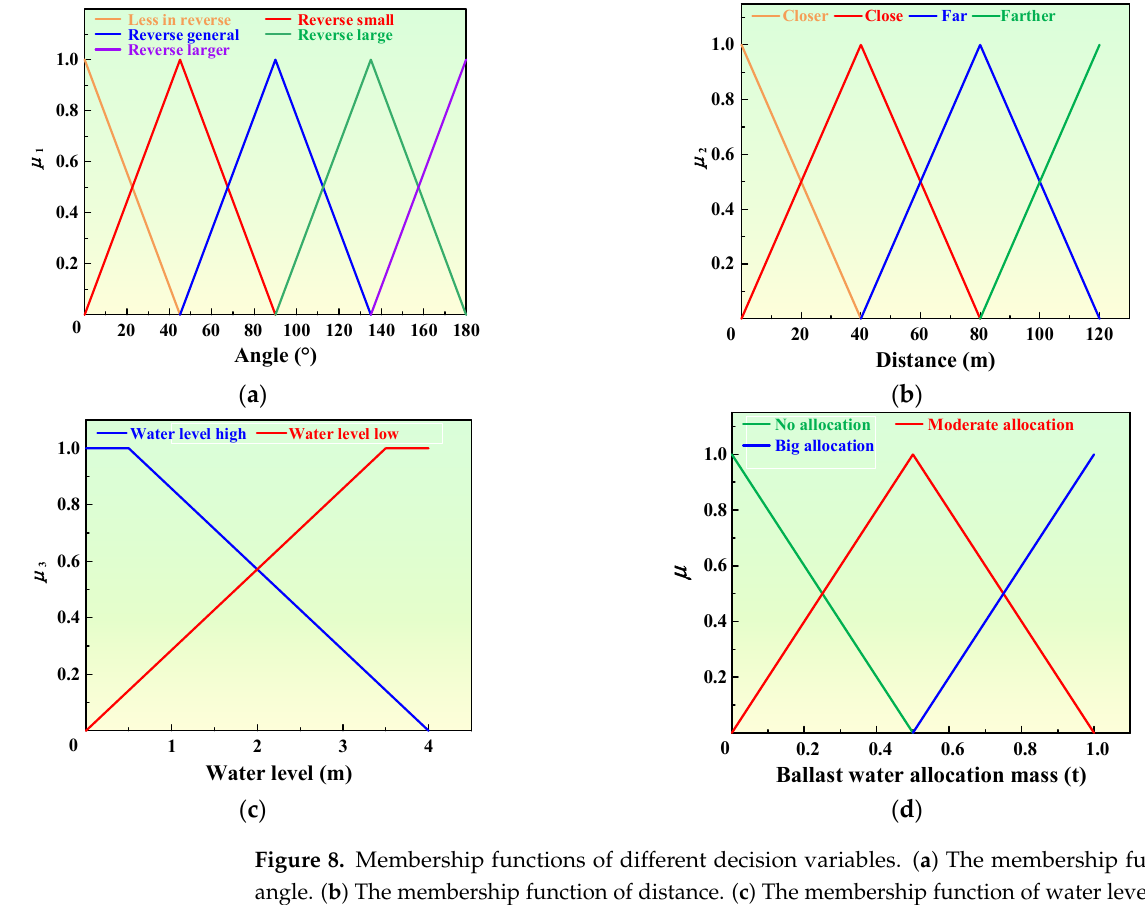
Figure 7. Schematic diagram of fuzzy set partition.